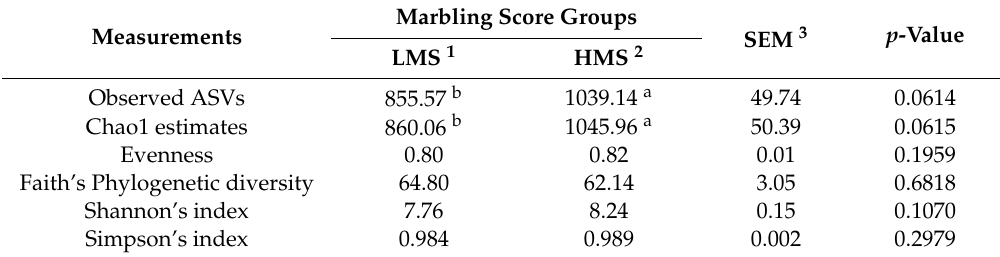
Table 2. Alpha-Diversity measurements of the prokaryotic microbiota in Hanwoo beef cattle.